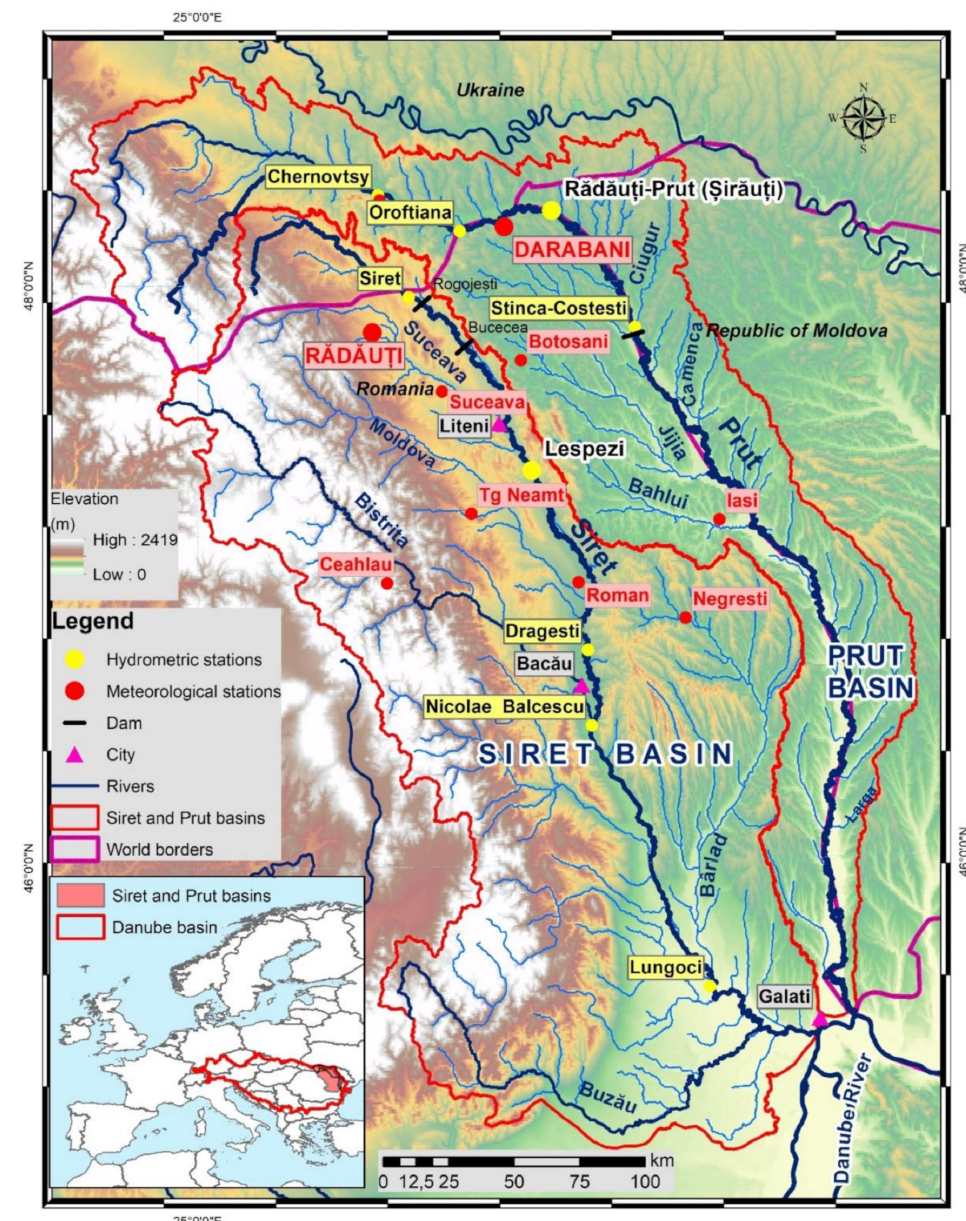
Figure 1. Location of the Siret and Prut catchment areas and the location of the gauging and meteorological stations used in this